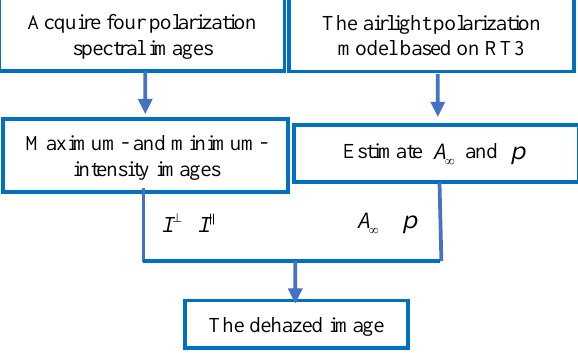
Figure 1. Flow chart of proposed dehazing